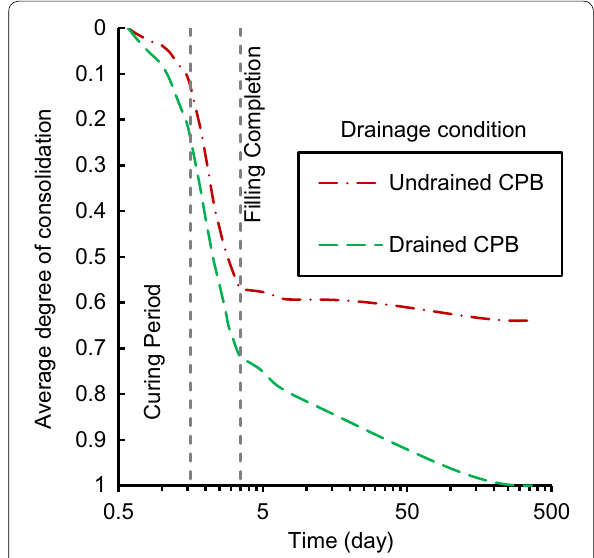
Fig. 20 Effect of drainage conditions on consolidation process of